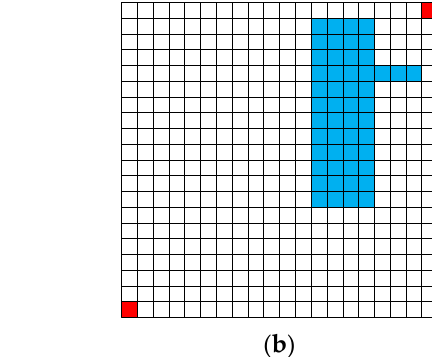
Table 8. Tuning range of the parameters.